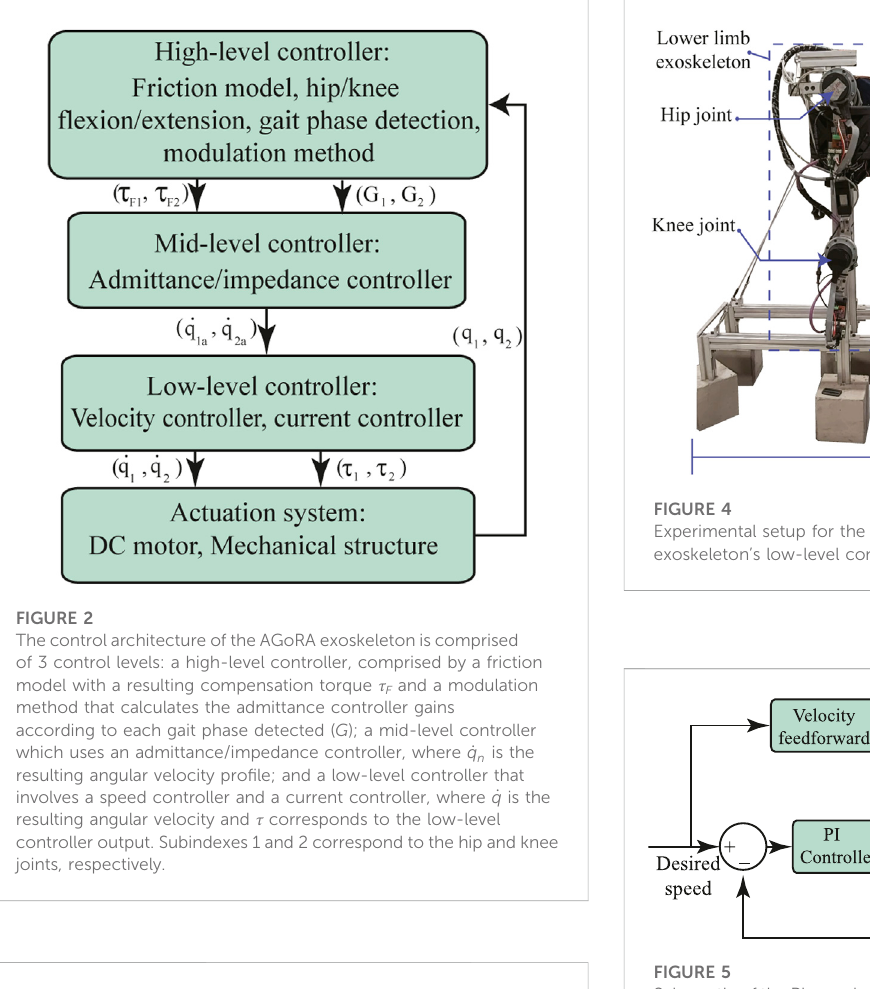
FIGURE 5 Schematic of the PI speed controller implemented in the AGoRA exoskeleton as a low-level controller.